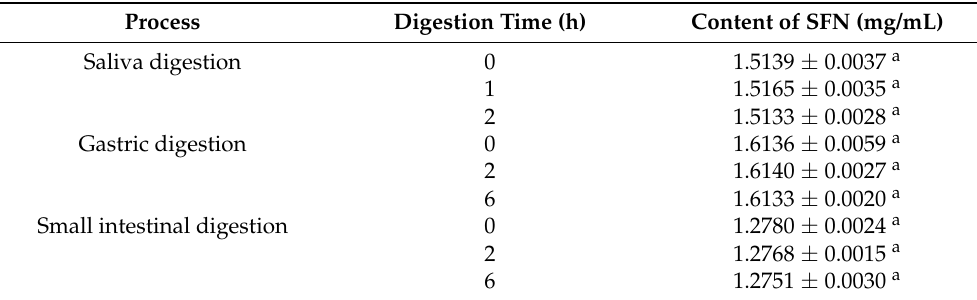
Figure 2. High performance liquid chromatogram (HPLC) of sulforaphane (SFN) after digestion in simulated saliva ( A ), simulated gastric fluid ( B ) and simulated small intestinal fluid ( C ). Table 1. Contents of SFN at different time points following saliva, simulated gastric and small intestinal